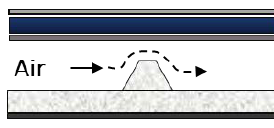
Figure 1. Section view of air-based PVT panel. Table 1. Main features of PVT panel.